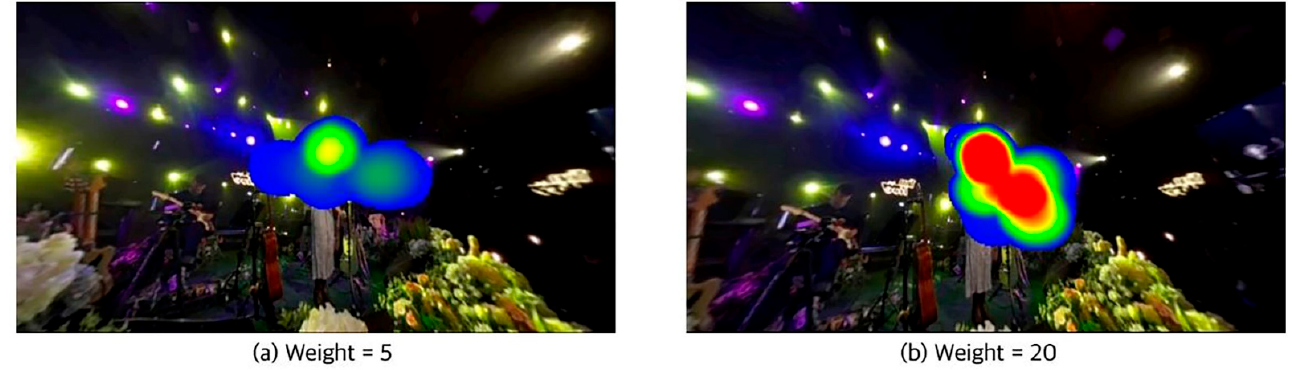
Figure 12. Heatmap comparison based on weight value.